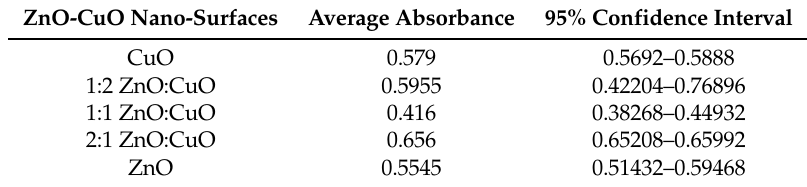
Table 2. Absorbance values associated with anti-mouse Ig-HRP on various nano-surfaces after washing (n = 2).